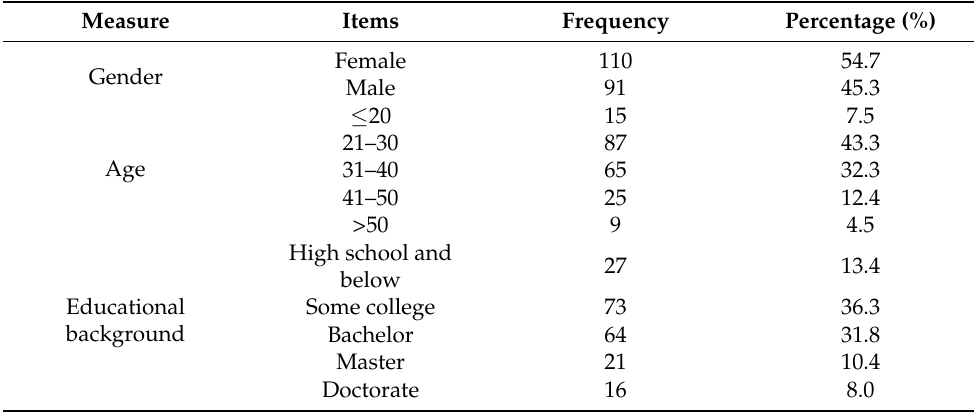
Table 1. Demographic distribution of the subjects.